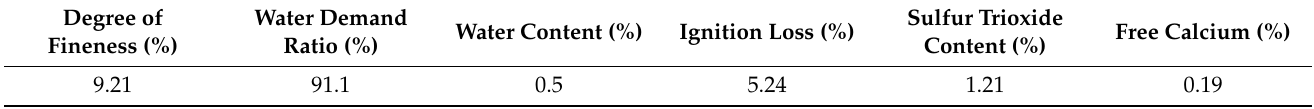
Table 2. Properties of coal fly ash.